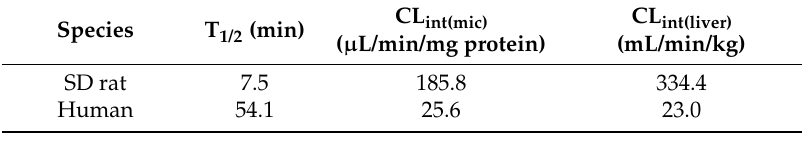
Table 1. Metabolic stability of ADC in SD rat and human liver microsomes following incubation in the presence of NADPH.